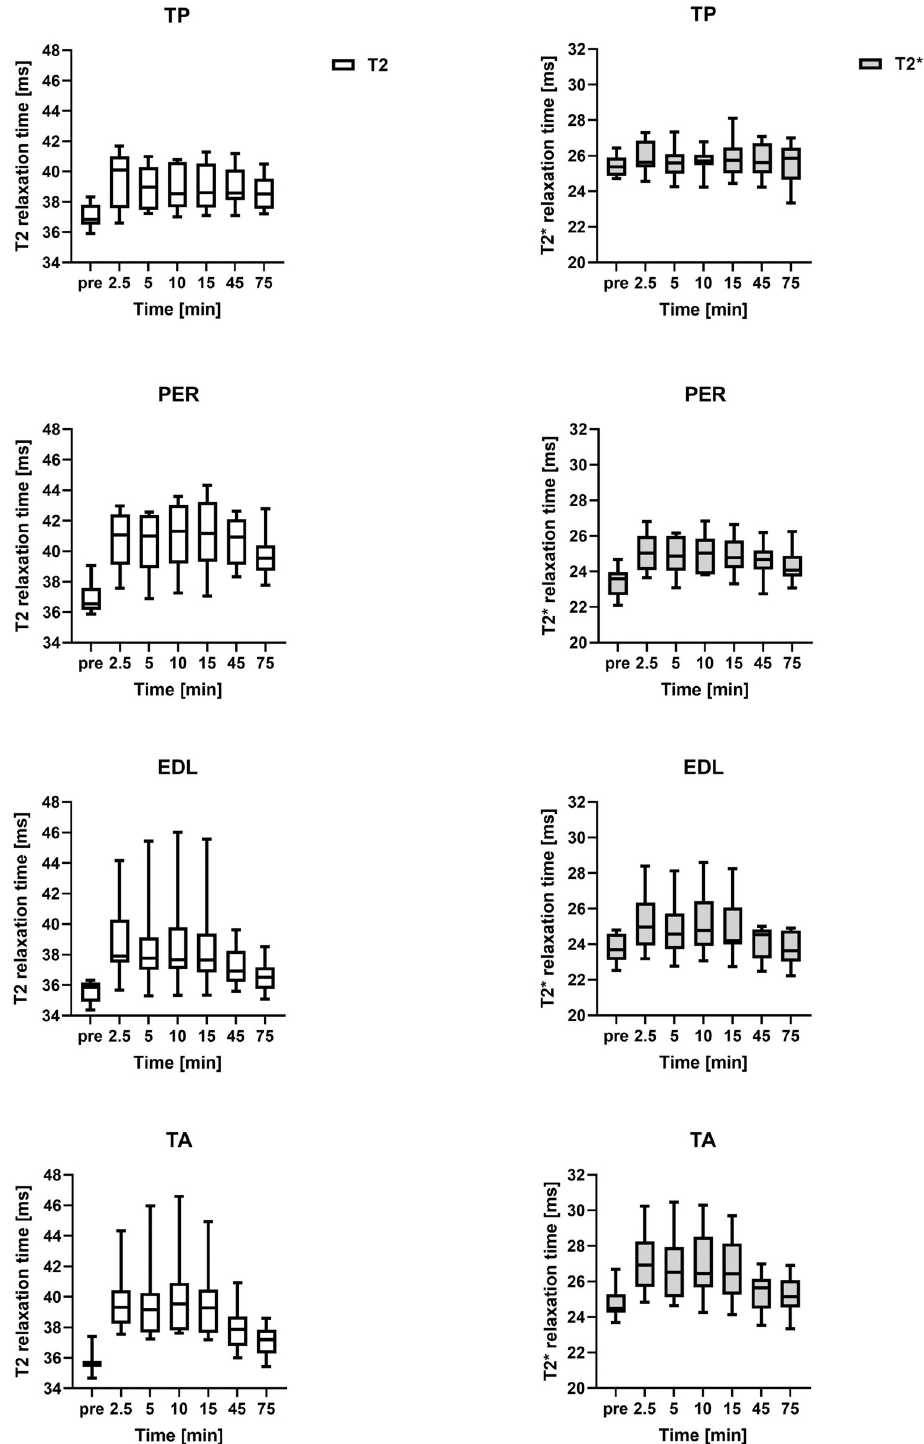
Fig 3. Mean T2 � and T2 relaxation time of the 10 participants. Abbreviations: TP = tibialis posterior muscle, PER = peroneus longus muscle, EDL = extensor digitorum longus muscle, TA = tibialis anterior muscle. Note: the time intervals between the time points indicated in the x-axis are